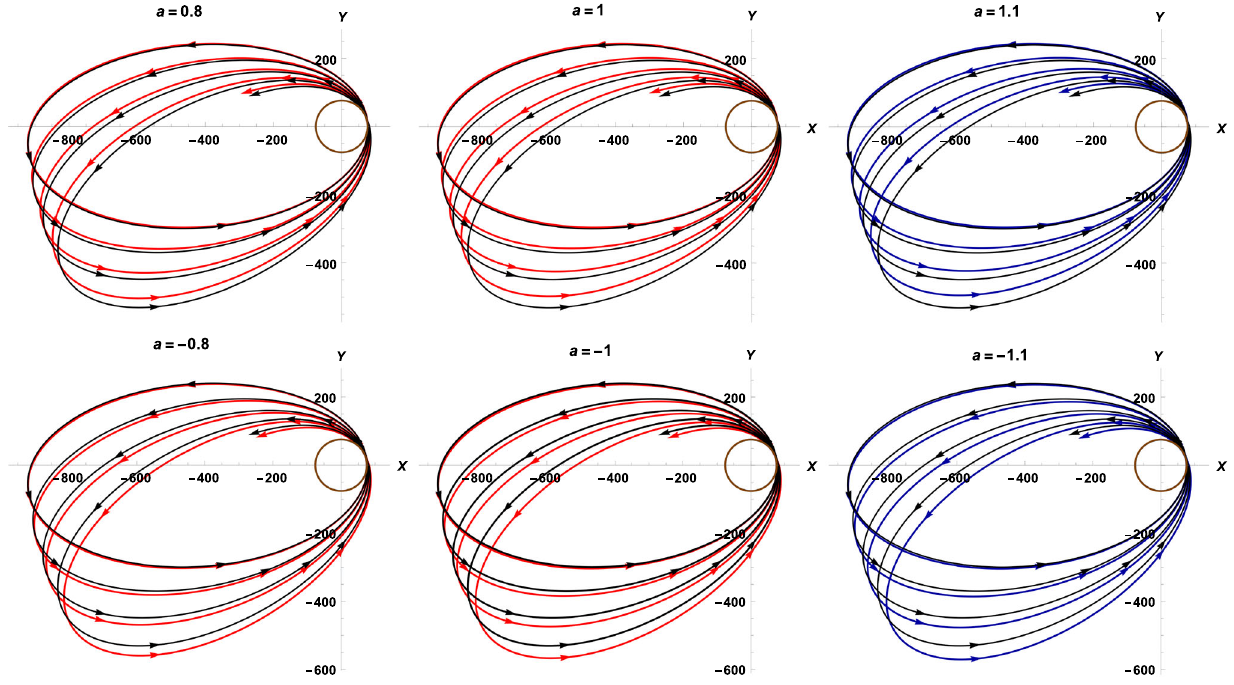
Fig. 1 Above figures show orbits of a test particle in the Kerr space- time. Red solid lines indicate particle’s orbits in the Kerr black hole for a = 0 . 8 , r min = 76 . 15 and a = − 0 . 8 , r min = 75 . 53 (first col- umn), in the extreme Kerr black hole for a = 1 , r min = 76 . 22 and a = − 1 , r min = 75 . 45 (second column) and blue solid lines indicate particle’s orbits in the Kerr naked singularity for a = 1 . 1 , r min = 76 . 25